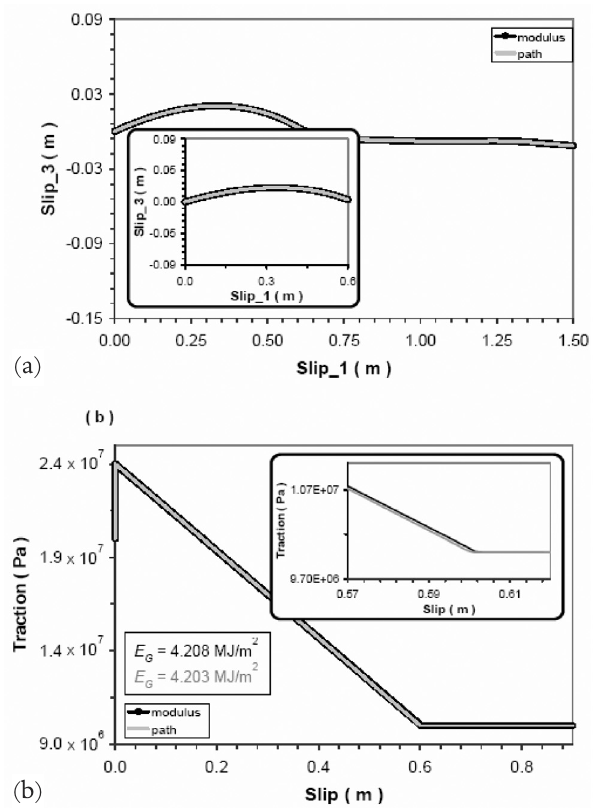
Figure 5. The same as Figure 3, but now in the case of Model B. The fault receiver is the same as in Figure